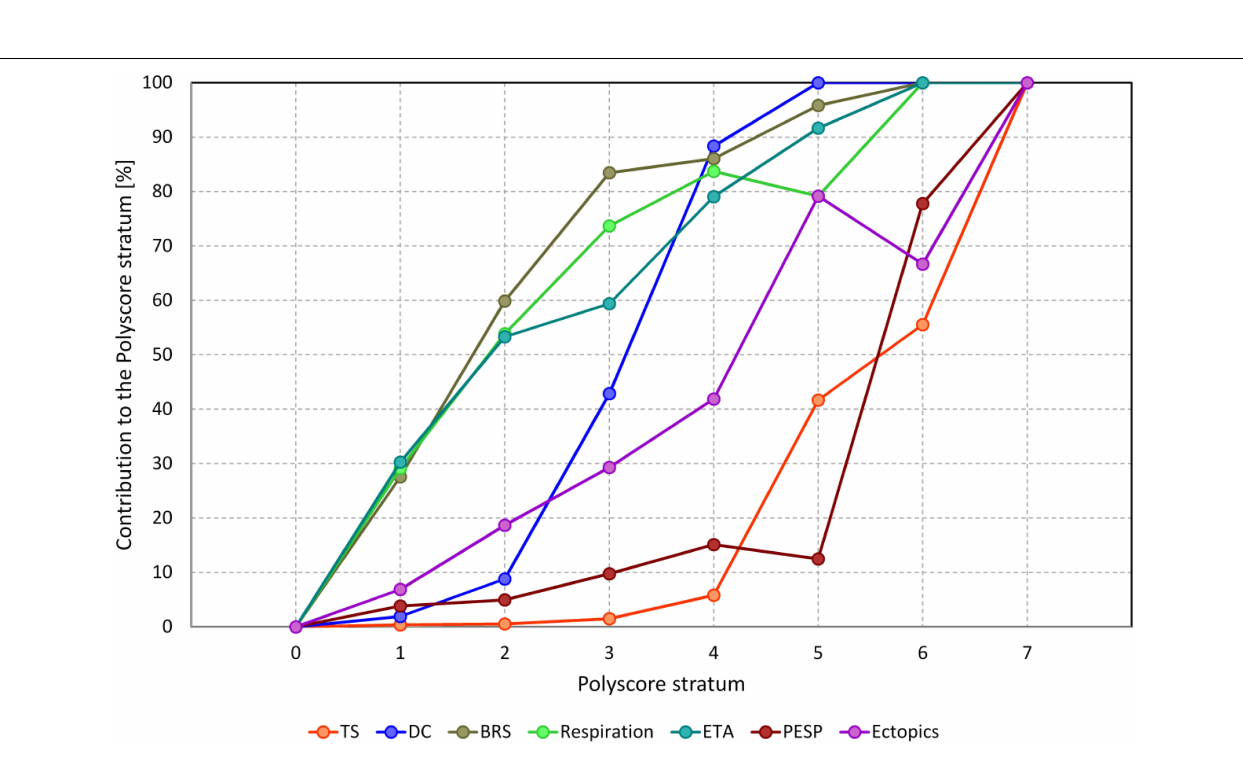
Frontiers in Physiology |